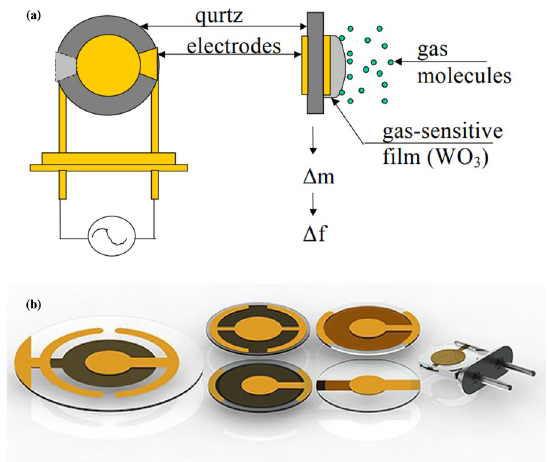
Fig. 9 Schematic of quartz crystal microbalance, ( a ) presents the QCM for gas molecules detection, ( b ) shows the different structures of the QCM